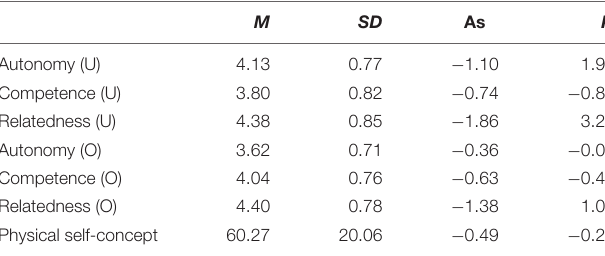
TABLE 3 | Satisfaction of basic psychological needs in unstructured and organized activities, physical self-concept, and weekly